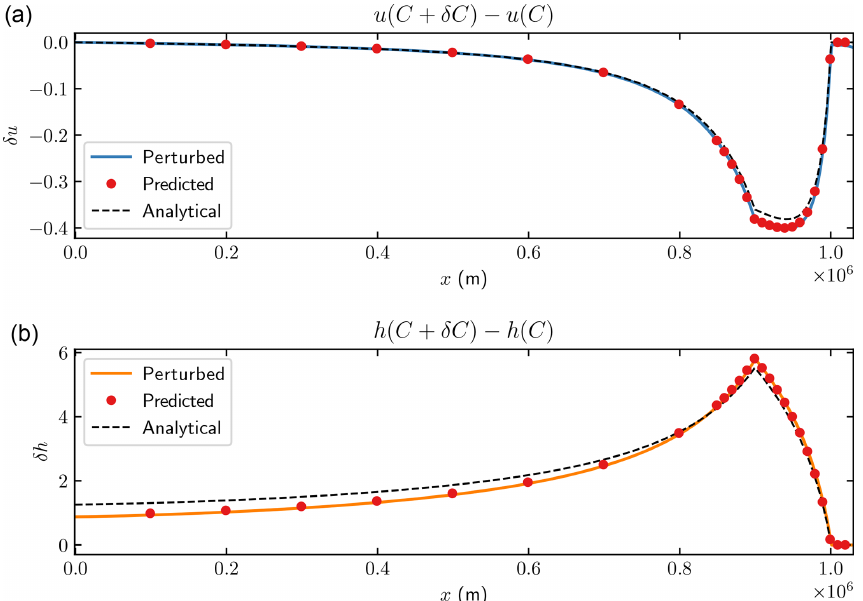
Figure 12. The changes in the horizontal velocity u (a) and surface elevation h (b) for SSA after 15000 years (close to the steady state) with 1% perturbation of C(x) in x ∈ [ 0 . 9 , 1 . 0 ]× 10 6 . Solid lines are the differences between the steady-state and perturbed solutions in Eq. (13). Red dots represent the estimated perturbation using Eq. (15).